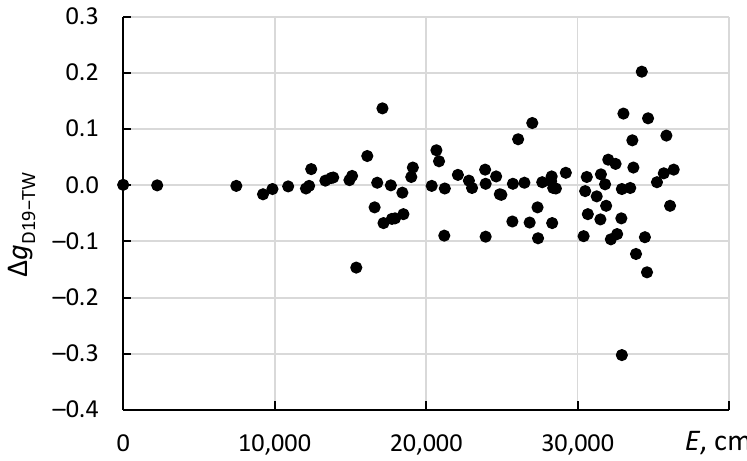
Figure 3. Differences of Landé g -factors calculated by Dzuba et al. [3] from those computed in the present work in a least-squares fitting with Cowan’s codes.